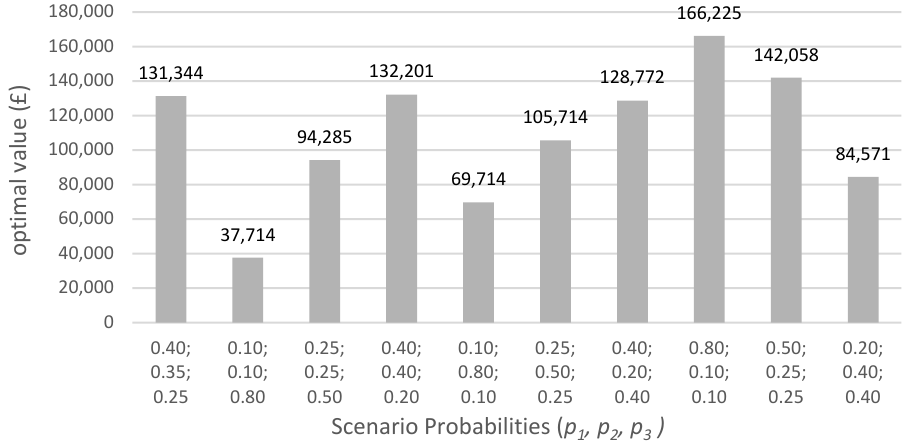
Figure 13. Optimal Value of the Objective Function as a function of scenario probabilities, using BIF.